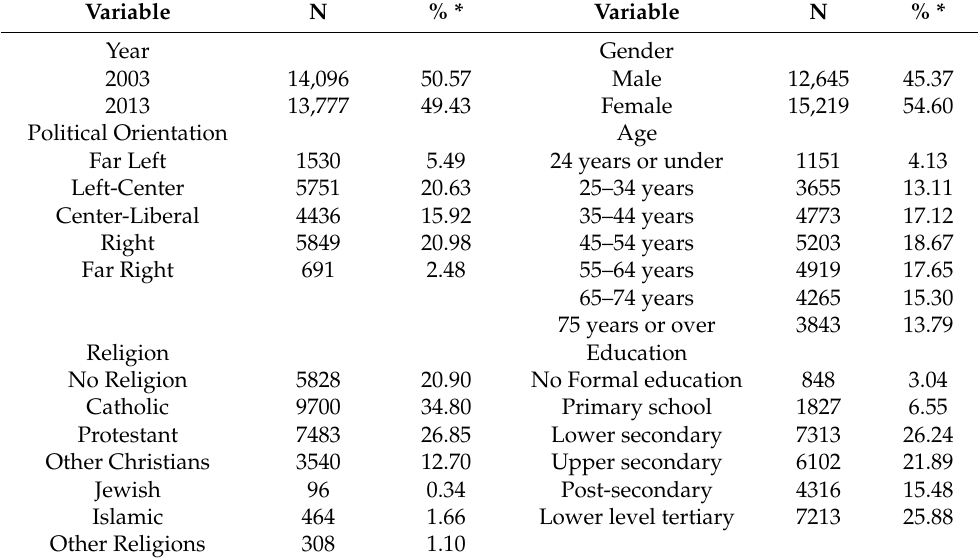
Table 1. Survey socio-demographic characteristics (N and %).